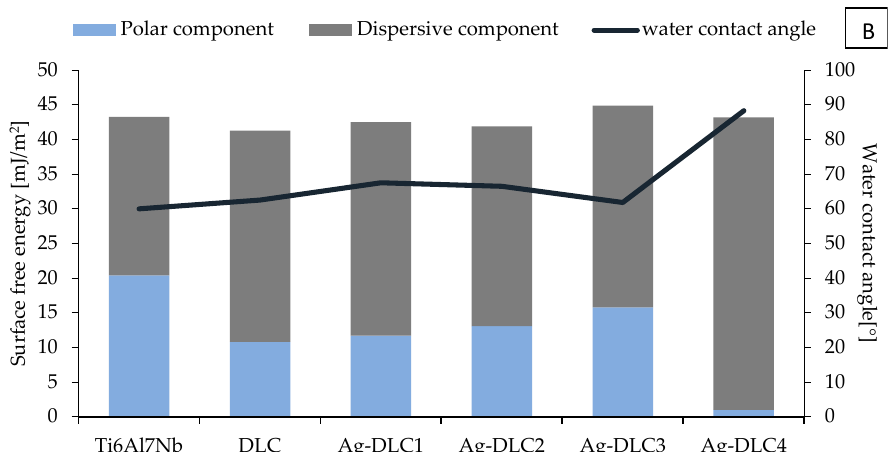
Figure 5. Surface energy components and contact angle for water of Ag-DLC coatings on AISI 316LVM ( A ) and Ti6Al7Nb ( B ) substrates.